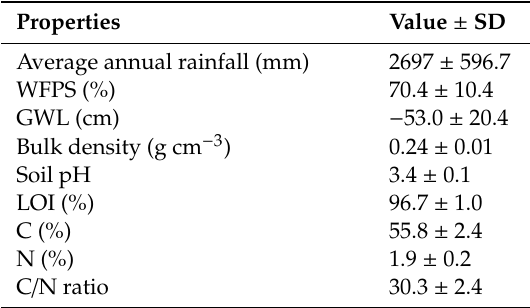
Table 3. Descriptions and physicochemical properties of soil at the study site (mean ± STD). WFPS: water-filled pore space; GWL: groundwater level; LOI: loss on